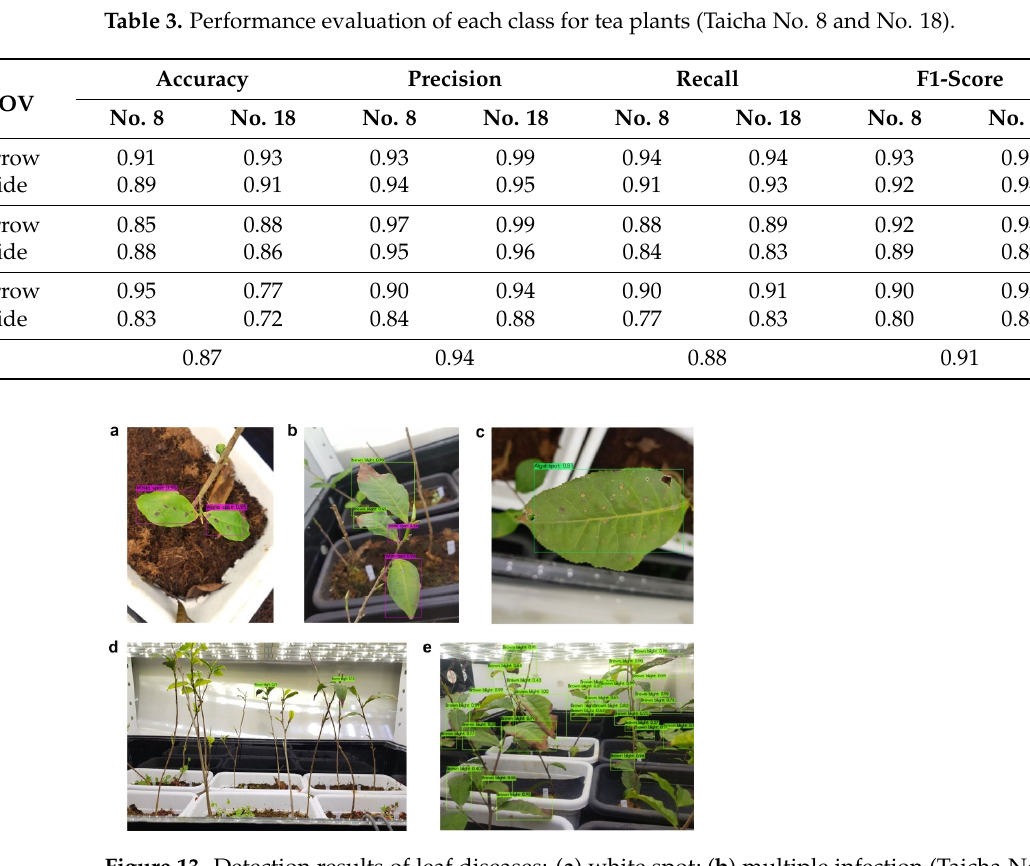
Figure 12. Detection of tea leaves in different cultivation zones with different types of angular field of view (AFOV). ( a ) Tea leaf detection for a single plant (Taicha No. 18). ( b ) Tea leaf detection for a tea plant (Taicha No. 8). ( c ) Results of detection of number of tea leaves in the zones with a wide AFOV for tea plants (Taicha No. 18). The purple and green colors represent the detected leaves of Taicha No. 18 and Taicha No. 8, respectively.